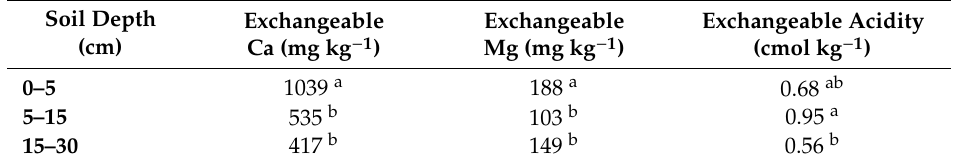
Table 8. Mean values of various soil measurements for the three depth increments. No common superscript letter indicates a significant ( p ≤ 0.05) difference.